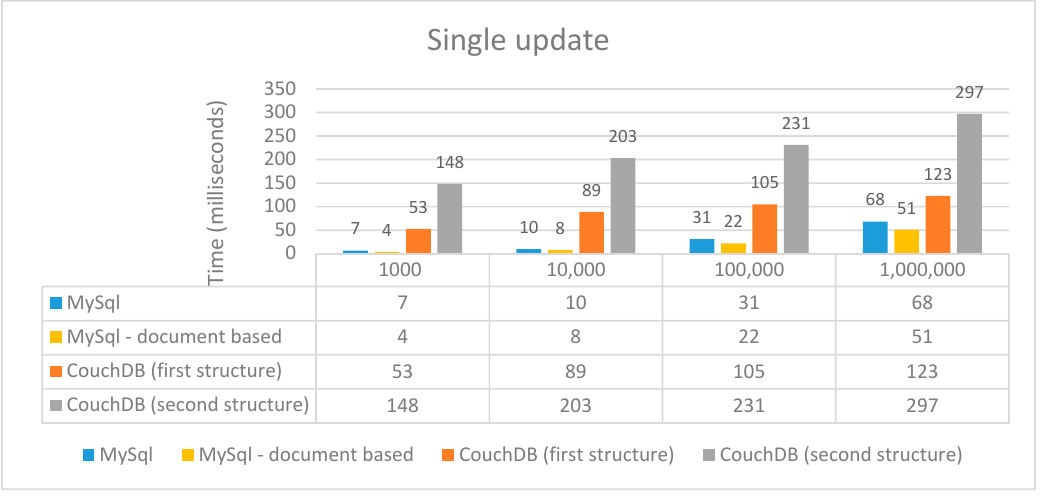
Figure 5. Performance time (ms) for the single update operation.